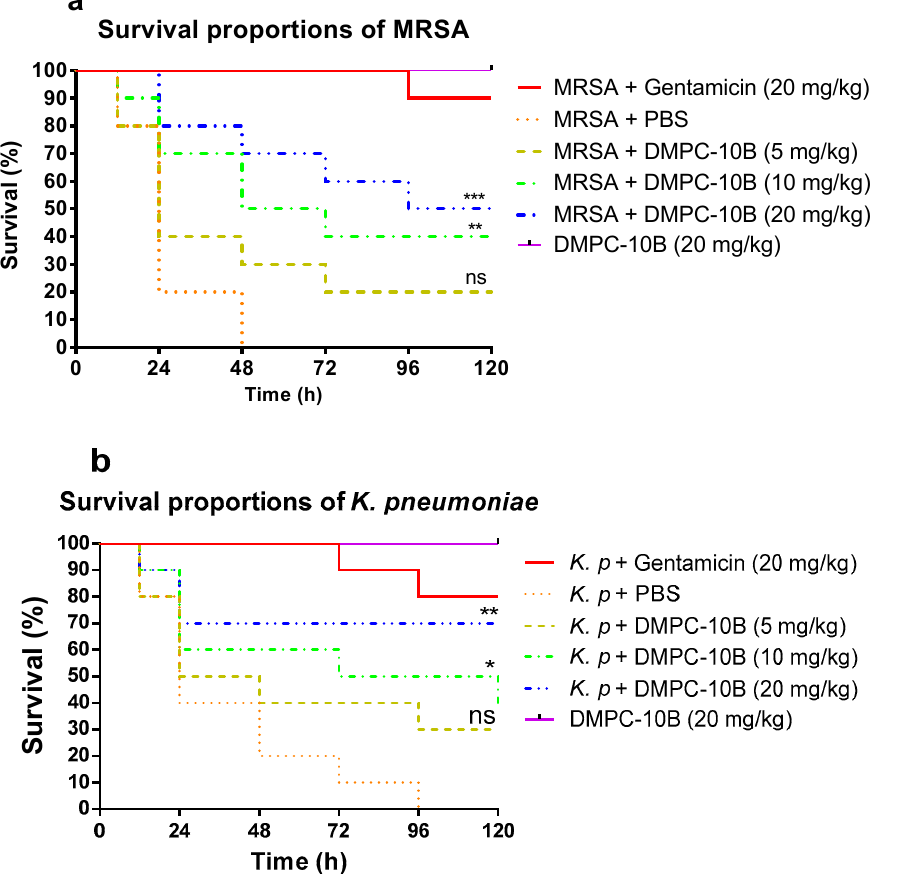
Figure 7. The mortality of Galleria mellonella larvae infected with ( a ) methicillin-resistant Staphylococcus aureus (MRSA) (NCTC 12493) and ( b ) K. pneumoniae (ATCC 43816). The infected larvae were treated with gentamicin (20 mg/kg), PBS, and different doses of DMPC-10B, respectively. The larvae without infection were treated with 20 mg/kg of DMPC-10B, which was applied to assess the potential toxicity of DMPC-10B to the hosts. The statistical analyses were performed by log-rank test to compare with the negative control (PBS treatment). The statistical significance is indicated as ns (nonsignificant difference), * ( p < 0.05), ** ( p < 0.01), and *** ( p < 0.001).